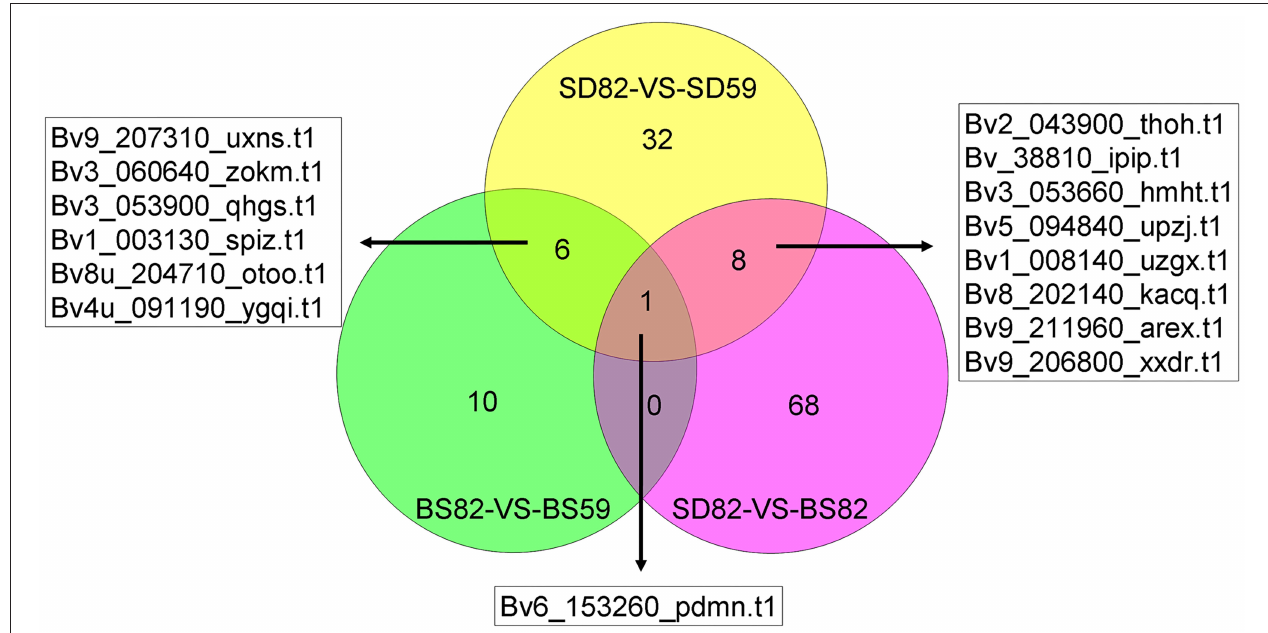
FIGURE 6 | Numbers of shared and unique enrichment cor-DEGs-DEPs in the BS82-VS-BS59, SD82-VS-SD59, and SD82-VS-BS82 groups, and the gene ID of shared enrichment cor-DEGs-DEPs were indicated.